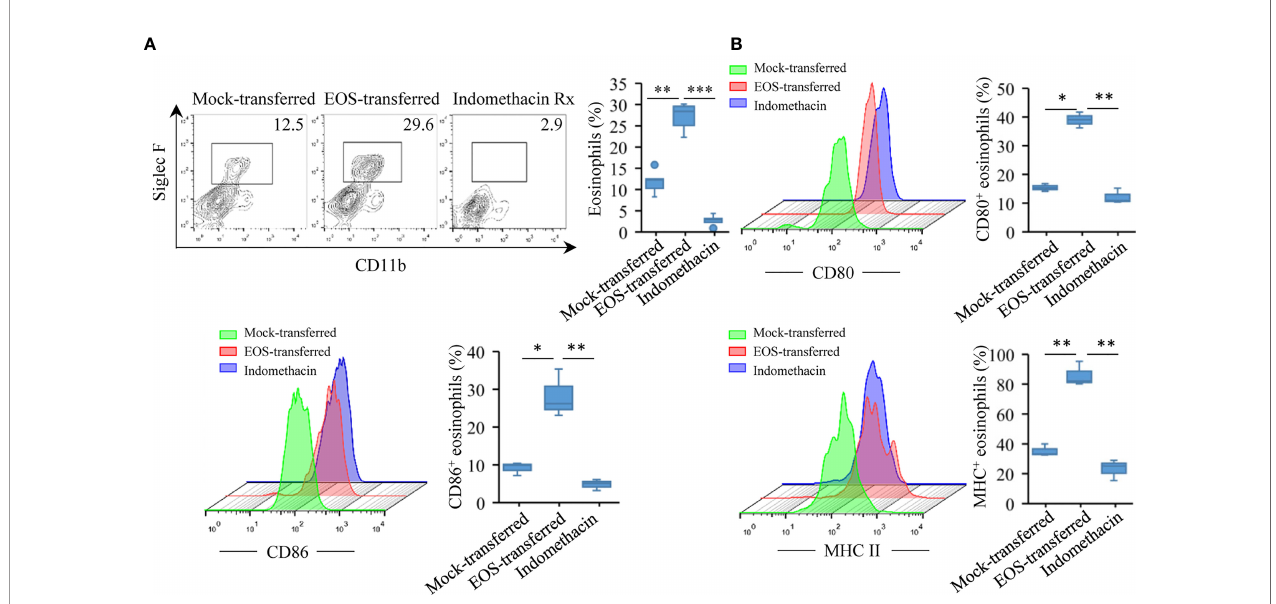
FIGURE 5 | Increased expression of MHC II, CD80, and CD86 molecules on lung eosinophils after adoptive transfer. (A) Using fl ow cytometry to verify the number of eosinophils in the lungs of three groups of mice. Quanti fi cation of eosinophils are presented as box plots ( n = 5). (B) CD80, CD86, and MHC II expression on eosinophil surface were monitored by fl ow cytometry in lung tissues of mice. Quanti fi cation of molecules are presented as box plots ( n = 3). Statistical results are shown: * p < 0.05, ** p < 0.01, and *** p <